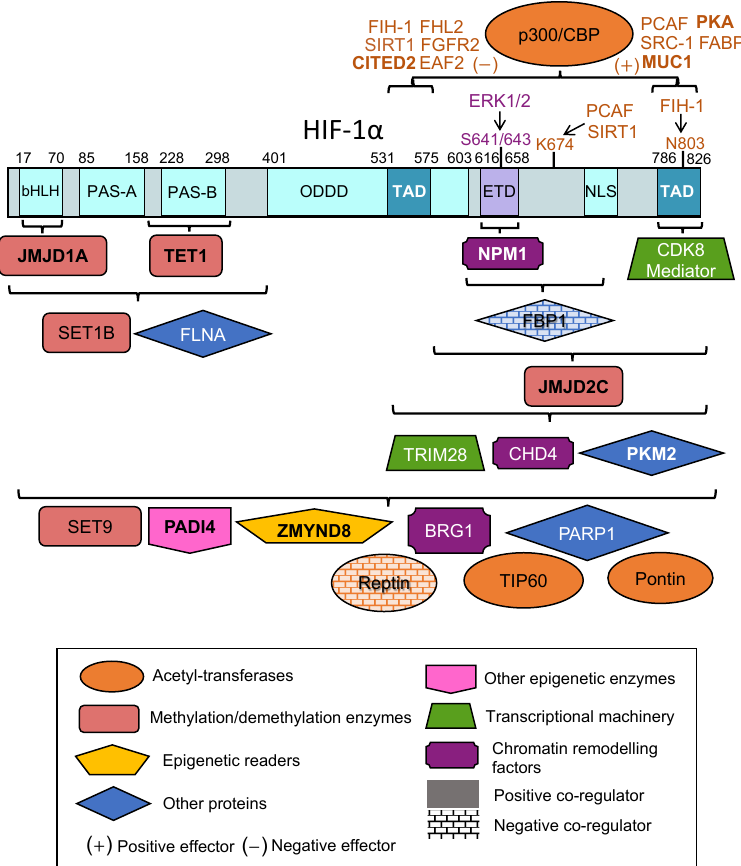
Figure 1. Schematic representation of HIF-1 α and its interacting co-regulators. Positive (+) and negative ( − ) effectors of the p300/CBP-HIF-1 α interaction are also shown. Brackets indicate the inter- acting region of HIF-1 α , in cases that this has been experimentally defined. Residues, modification of which is known to affect an interaction, are also indicated. Genes directly regulated by HIF-1 are shown in bold. See Table 1 and text for details and relevant